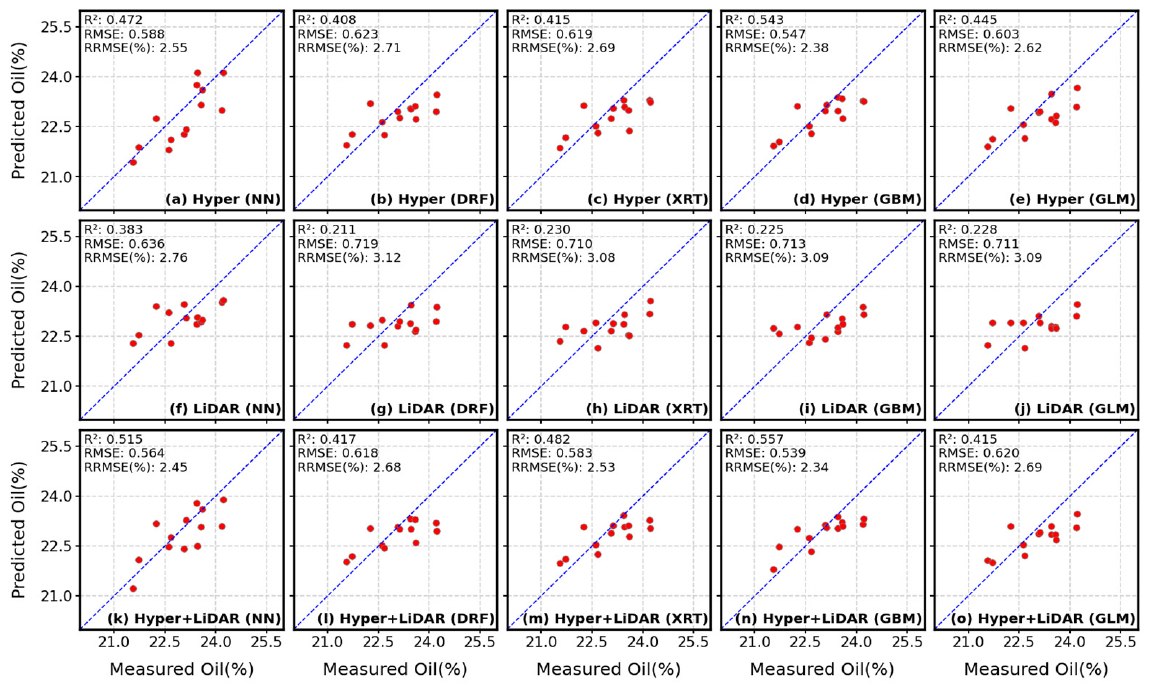
Figure 8. Scatter plots of measured vs. predicted soybean oil concentration using different models with hyper-based, LiDAR-based and Hyper + LiDAR-based features, respectively.